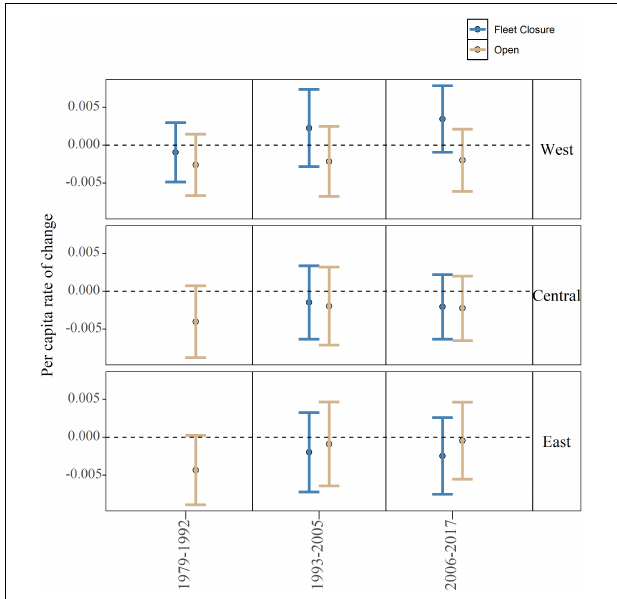
FIGURE 4 | Model estimated community level per capita rate of change for each period (1979–1992, 1993–2005, and 2006–2017), management type (closed and open), and sub-region (west, central, and east). Error bars represent 95% confidence intervals. Note that in 1979–1992, closures for the east and central sub-regions were not yet in